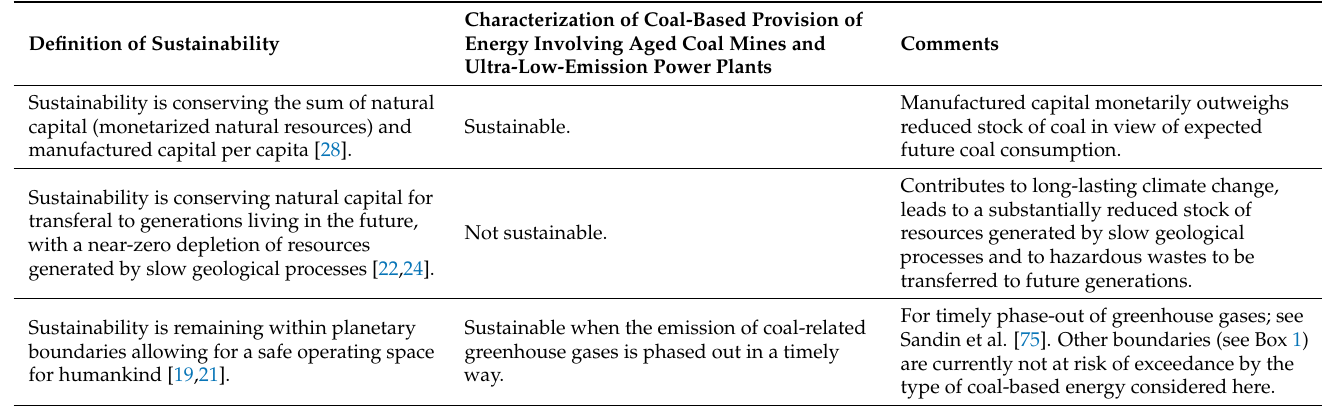
Table 3. The sustainability of coal-based energy involving aged coal mines and ultra-low-emission power plants using three definitions of sustainability.